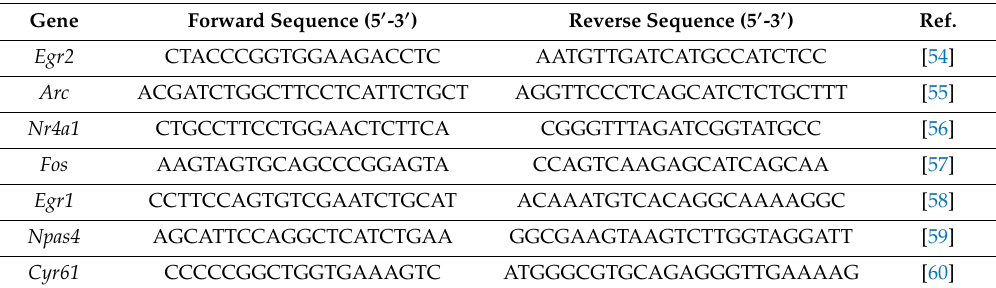
Table 4. Primer sequences for